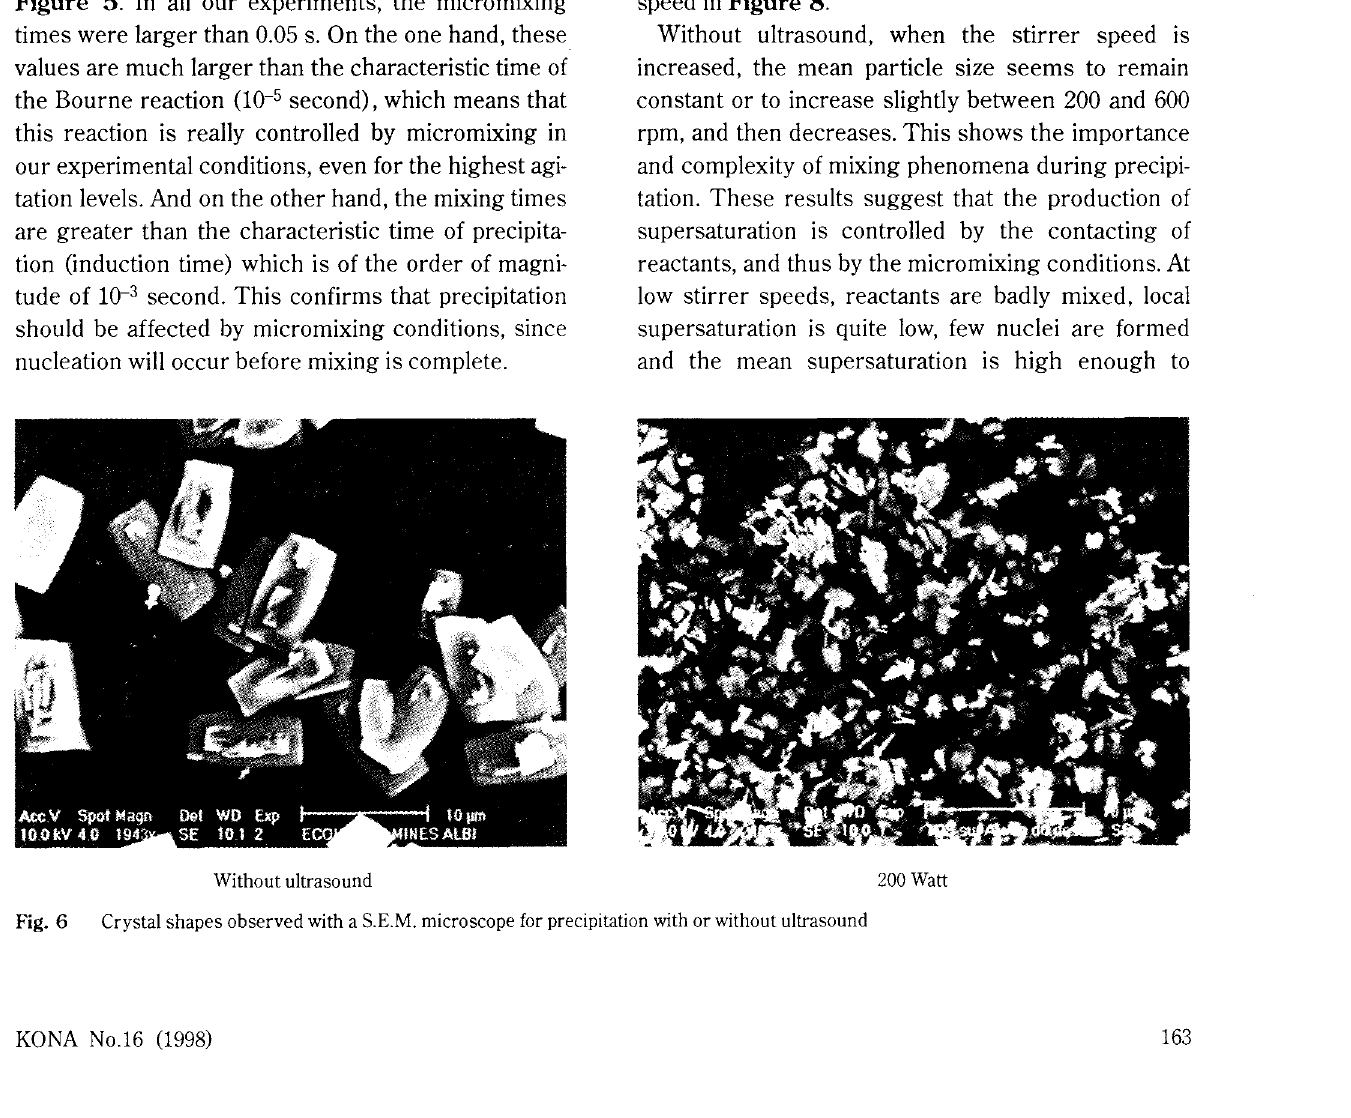
Fig. 6 Crystal shapes observed with a S.E.M. microscope for precipitation with or without ultrasound